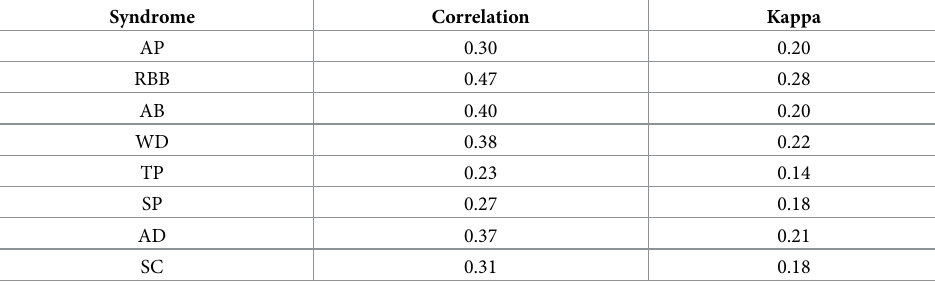
Table 1. Syndrome-level correlations and Kappa coefficients between CBCL and